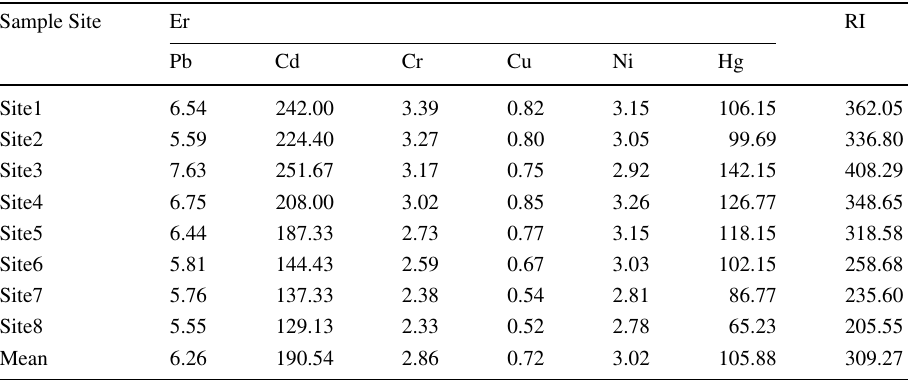
Table 8 Potential ecological i risk factors ( E r ) and potential ecological risk indexes (RI) of heavy metals in sediment